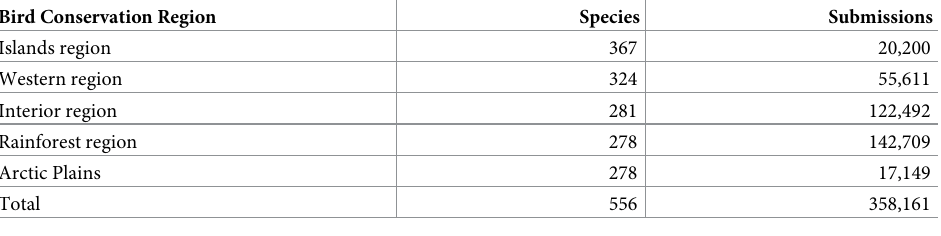
Table 1. Observed number of species and ebird submissions by Alaska Bird Conservation Region,